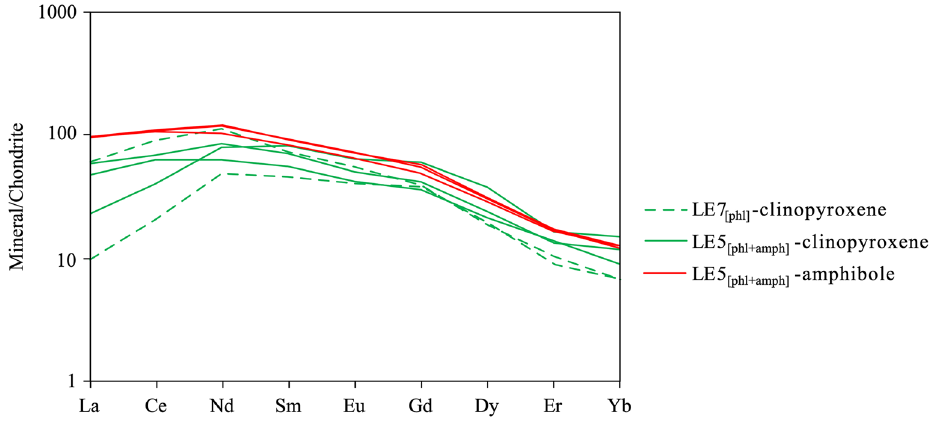
Figure 3. Chondrite normalized 53 REE patterns of clinopyroxene (green lines) and amphibole (red lines) of Mount Leura xenoliths.